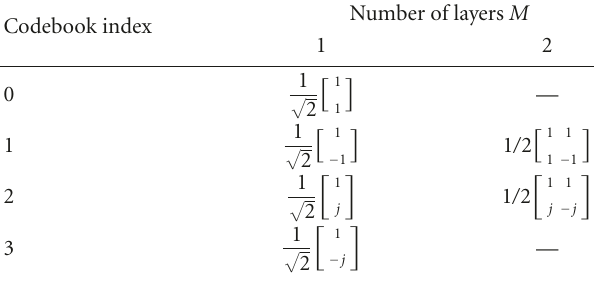
Table 1: Precoding codebook for transmission on two antennas. Codebook